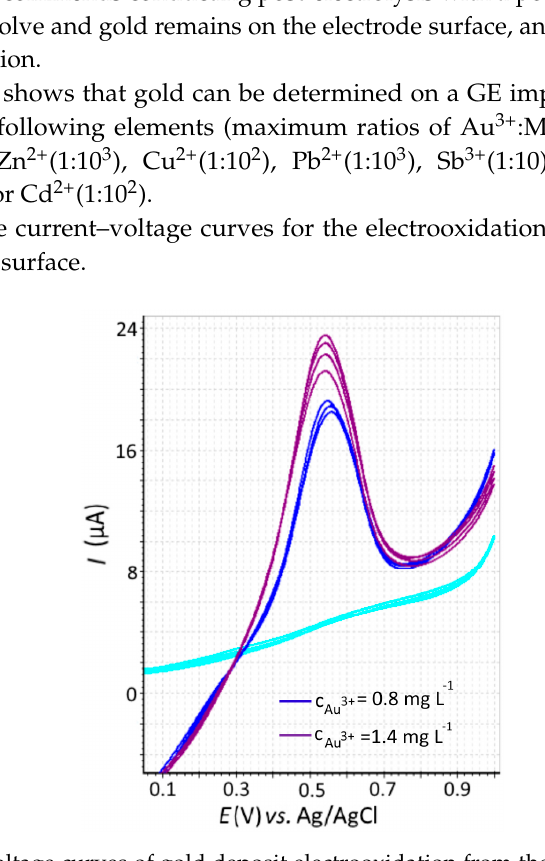
Figure 4. Current–voltage curves of gold deposit electrooxidation from the graphite electrode (GE) surface. Experimental conditions: medium of 1 mol L − 1 HCl, E e = − 0.7 V; τ e = 120 s; v = 0.06 V s − 1 .